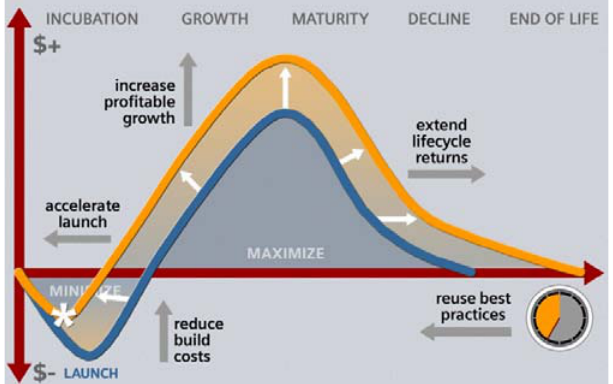
Figure 3. “PLM business